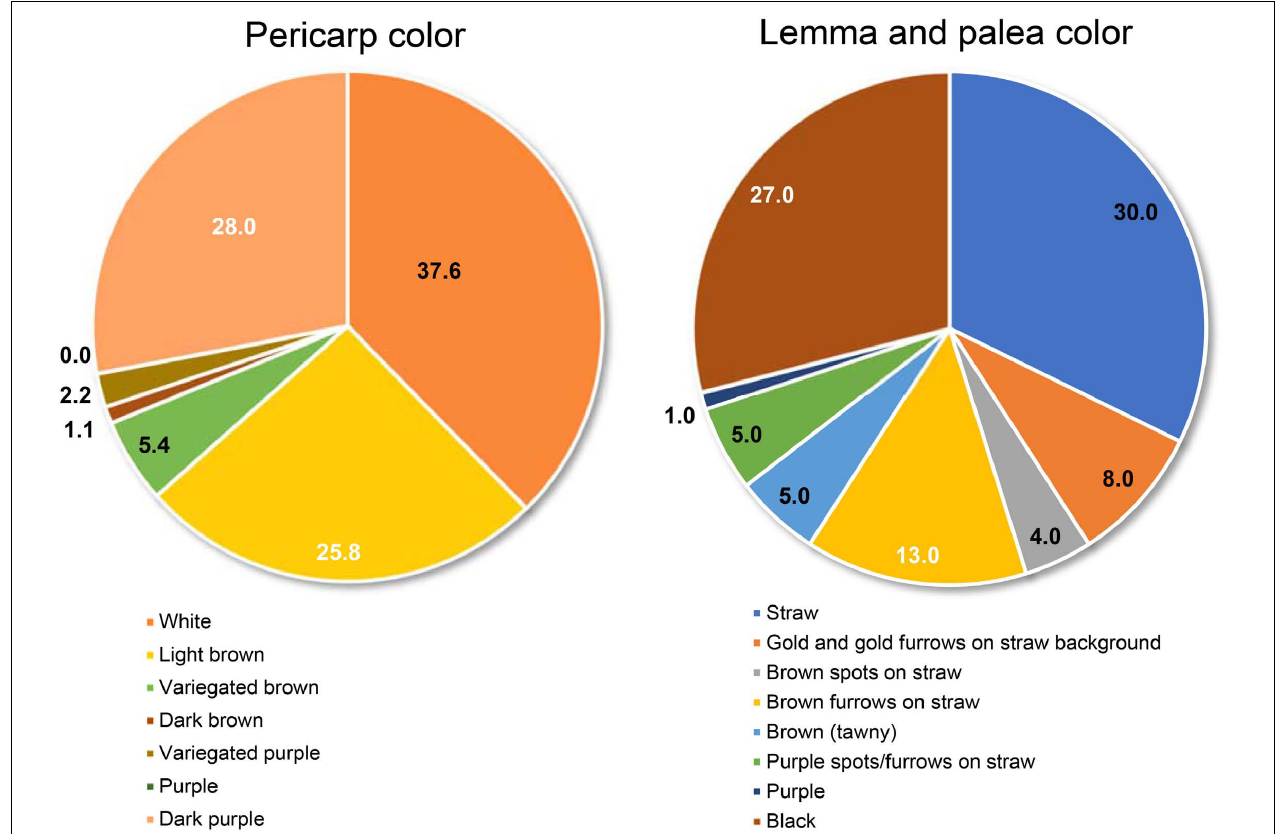
FIGURE 3 | Distribution of genotypes based on the phenotypic variation for grain coloration in the aromatic rice germplasm of